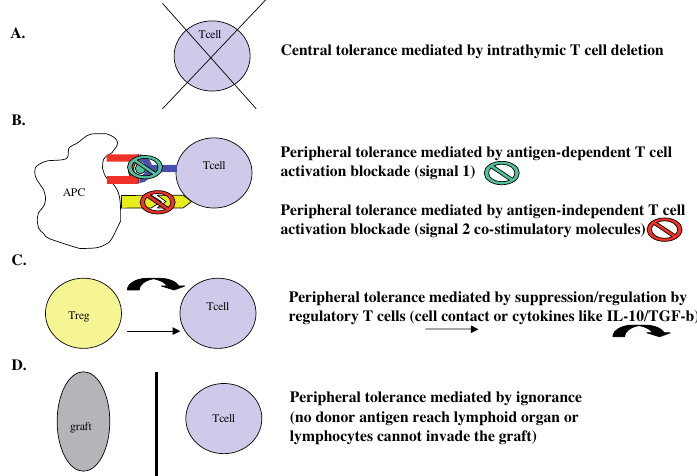
Mechanism of tolerance induction in organ transplantation. ( A) Central deletion can be achieved by direct injection of donor cells into the thymus but in clinical practice colonisation of the thymus by donor haematopoietic cells ensures a continuous supply of donor antigen in the thymus leading to negative selection of the immature T cell. (B) Peripheral tolerance can be achieved by the depletion of T lympho- cytes with monoclonal antibody to remove al- loreactive T cells without specificity. Blocking the co-stimulatory molecules prevents T cells from activation, leading to anergy. (C ) Regula- tory T cells inhibit T-cell activation by cell-cell contact and/or secretion of anti-inflammatory cytokines such as TGF- b or IL-10. Regulatory T cells could also maintain dendritic cells in an immature and tolerogenic state [55]. (D ) Igno- rance is achieved in very specific conditions such as non-vascularised organ transplantation (i.e corneal